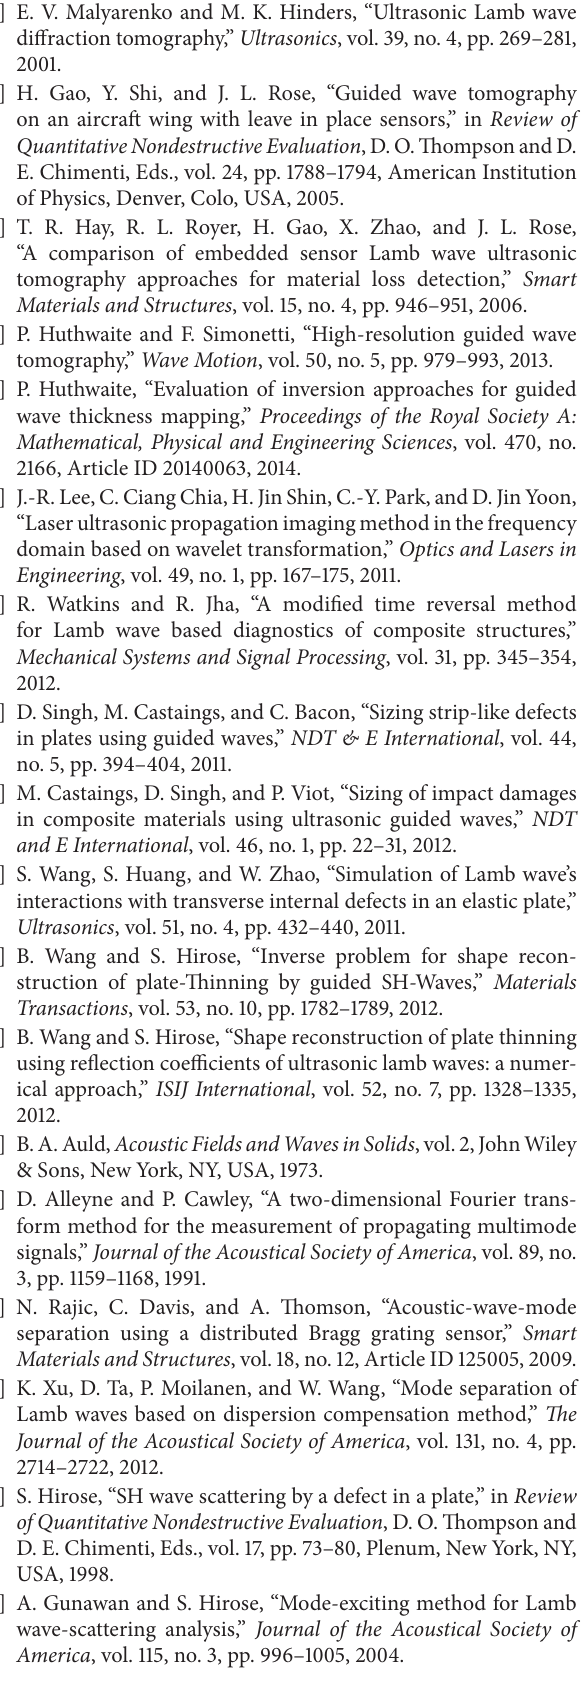
Mode- 0 Born approx. Mode- 0 numerical